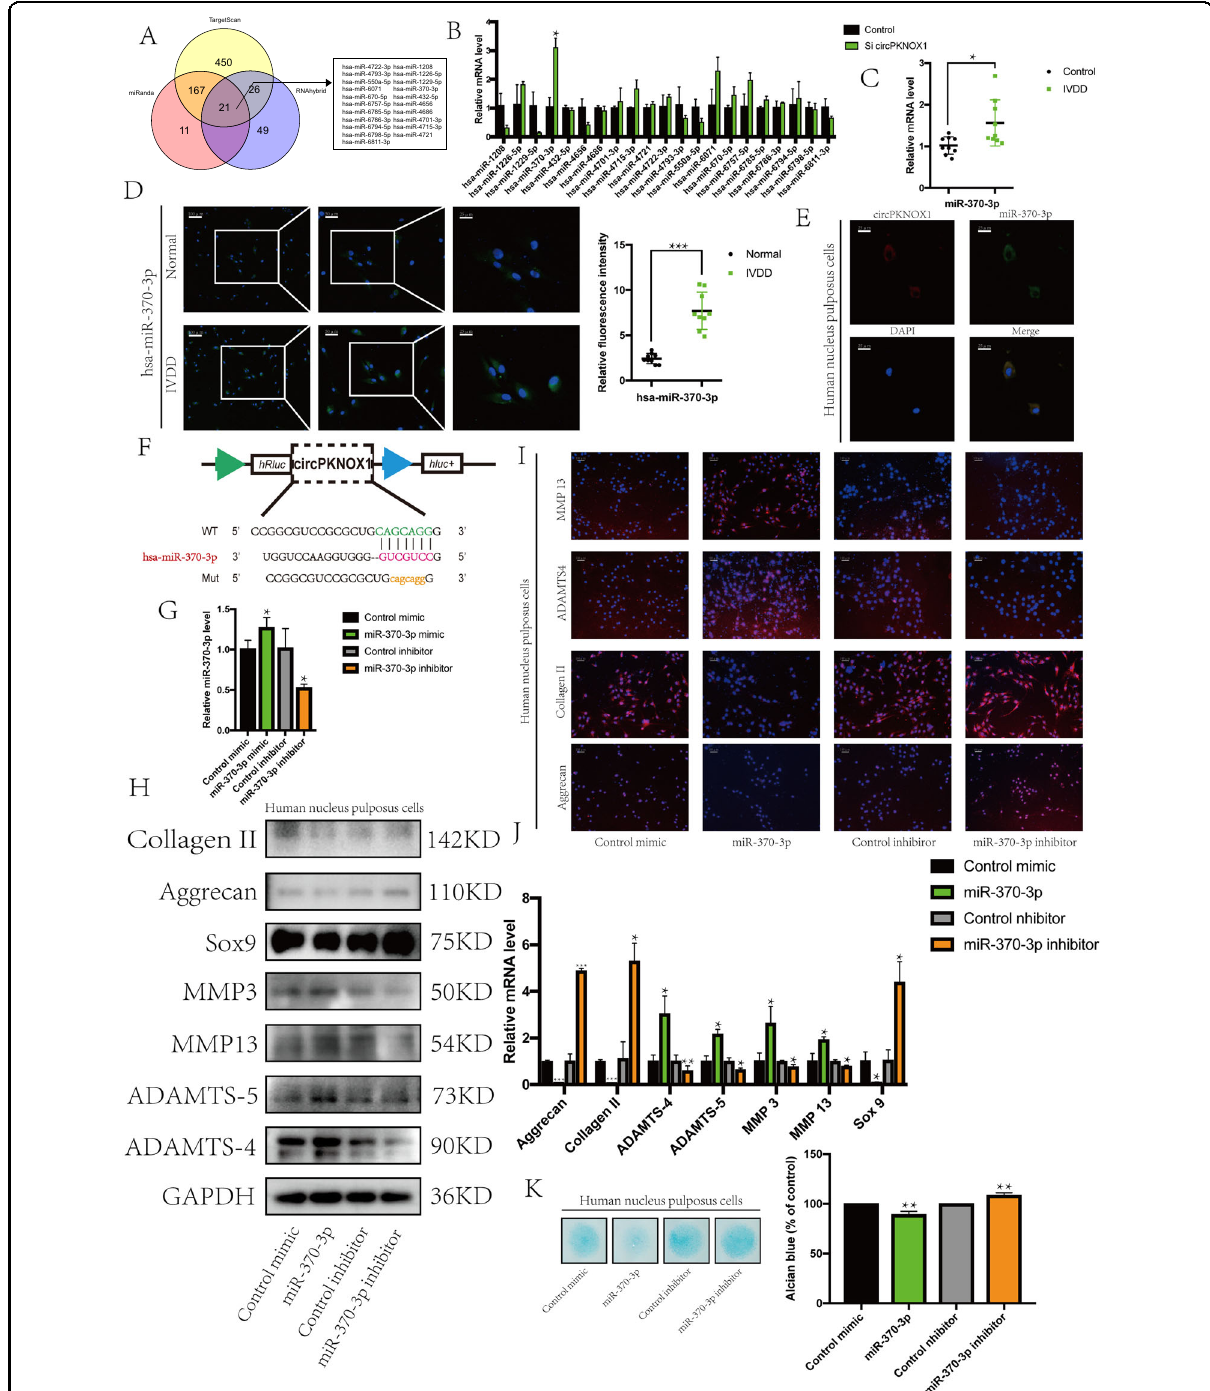
pathological group comprised of patients with herniated discs ( n = 49). Patient information is provided in Sup- plementary Table S1 32